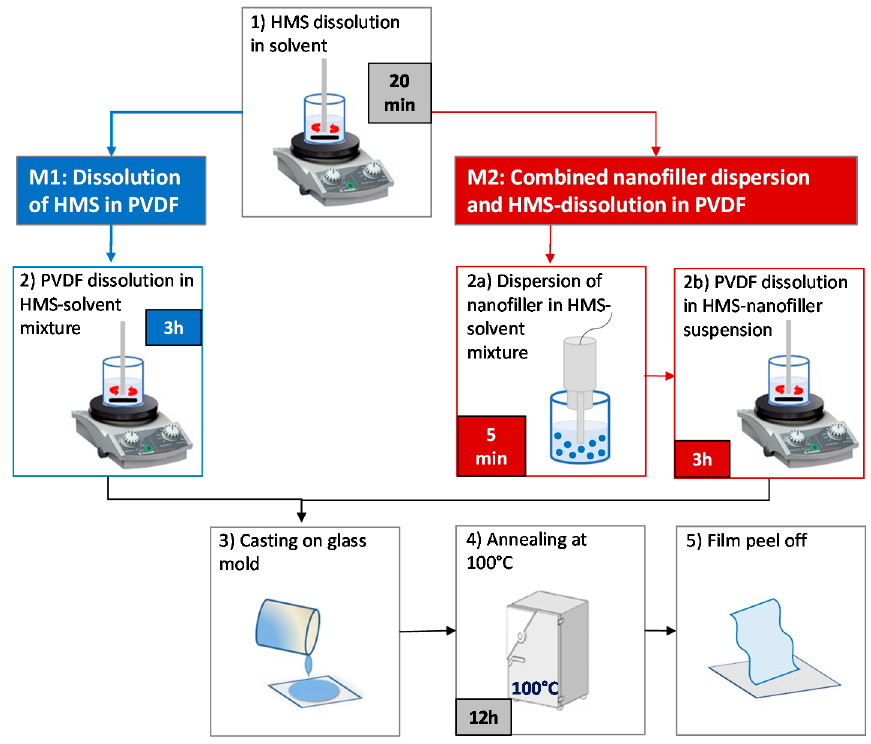
Figure 1. Schematic illustration of the solution-derived PVDF nanocomposite thin film preparation process.